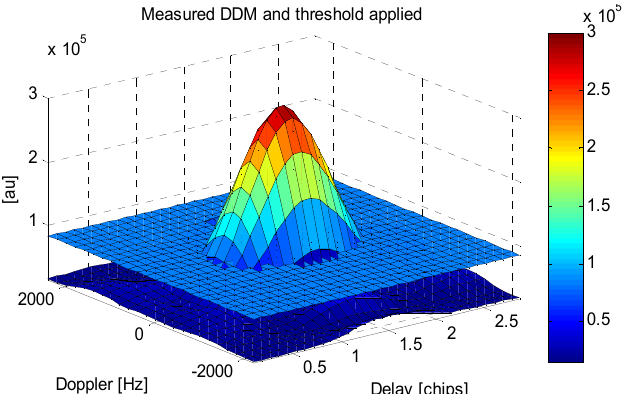
Figure 18. Measured (not normalized, in arbitrary units) one second incoherently averaged Delay-Doppler Map (DDM) with the threshold applied to compute the volume contained by it. Noise is well below the threshold (from